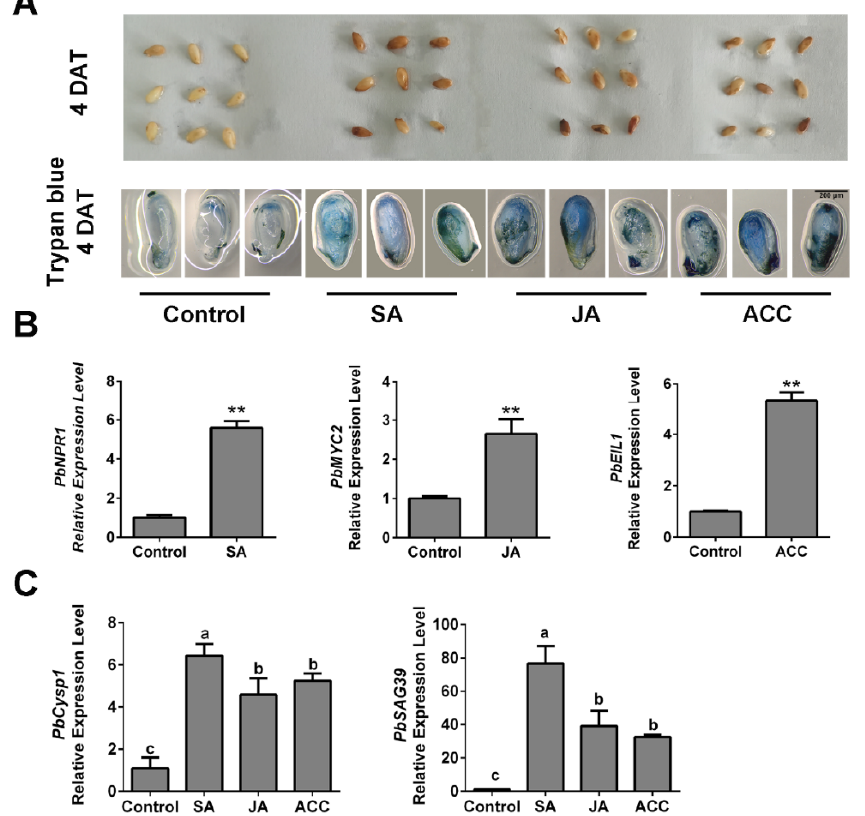
Figure 5. In vitro assay, application of ACC, SA and JA promotes normal seed death. ( A ) Observation of the seed development after treating with ACC, SA and JA respectively, and trypan blue staining assay demonstrated the cell death of different treated ovules. ( B ) Expression level analysis of the SA, JA and ethylene signaling response-related genes. ( C ) The expression of senescence-related genes PbCysp1 and PbSAG39 verified the seed death. The data are mean ± SD of three biological replicates. Error bars represent the standard deviation. Asterisks indicate significant difference at ** p < 0.01 (Student’s t -test). Different lowercase letters indicate significant difference at p < 0.05 (Duncan’s multiple range test) .